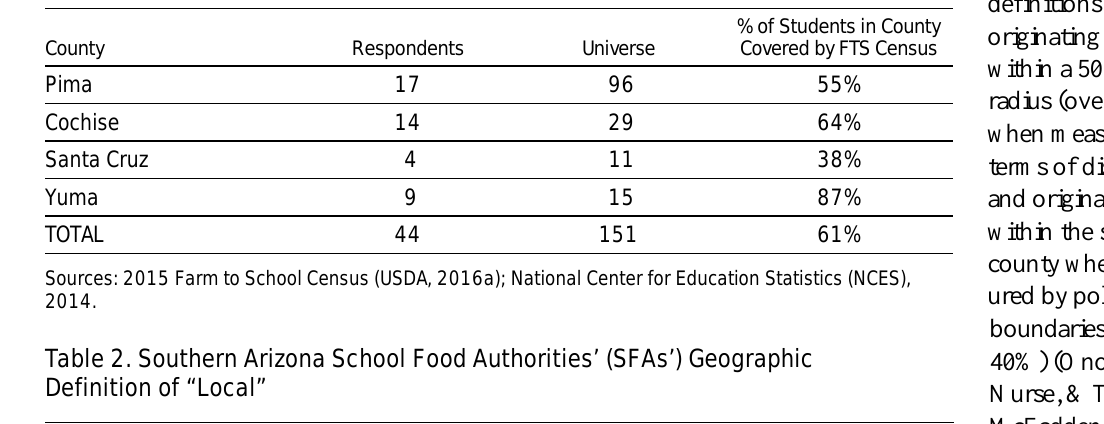
Table 1. Southern Arizona Farm to School (FTS) Census Respondents by County